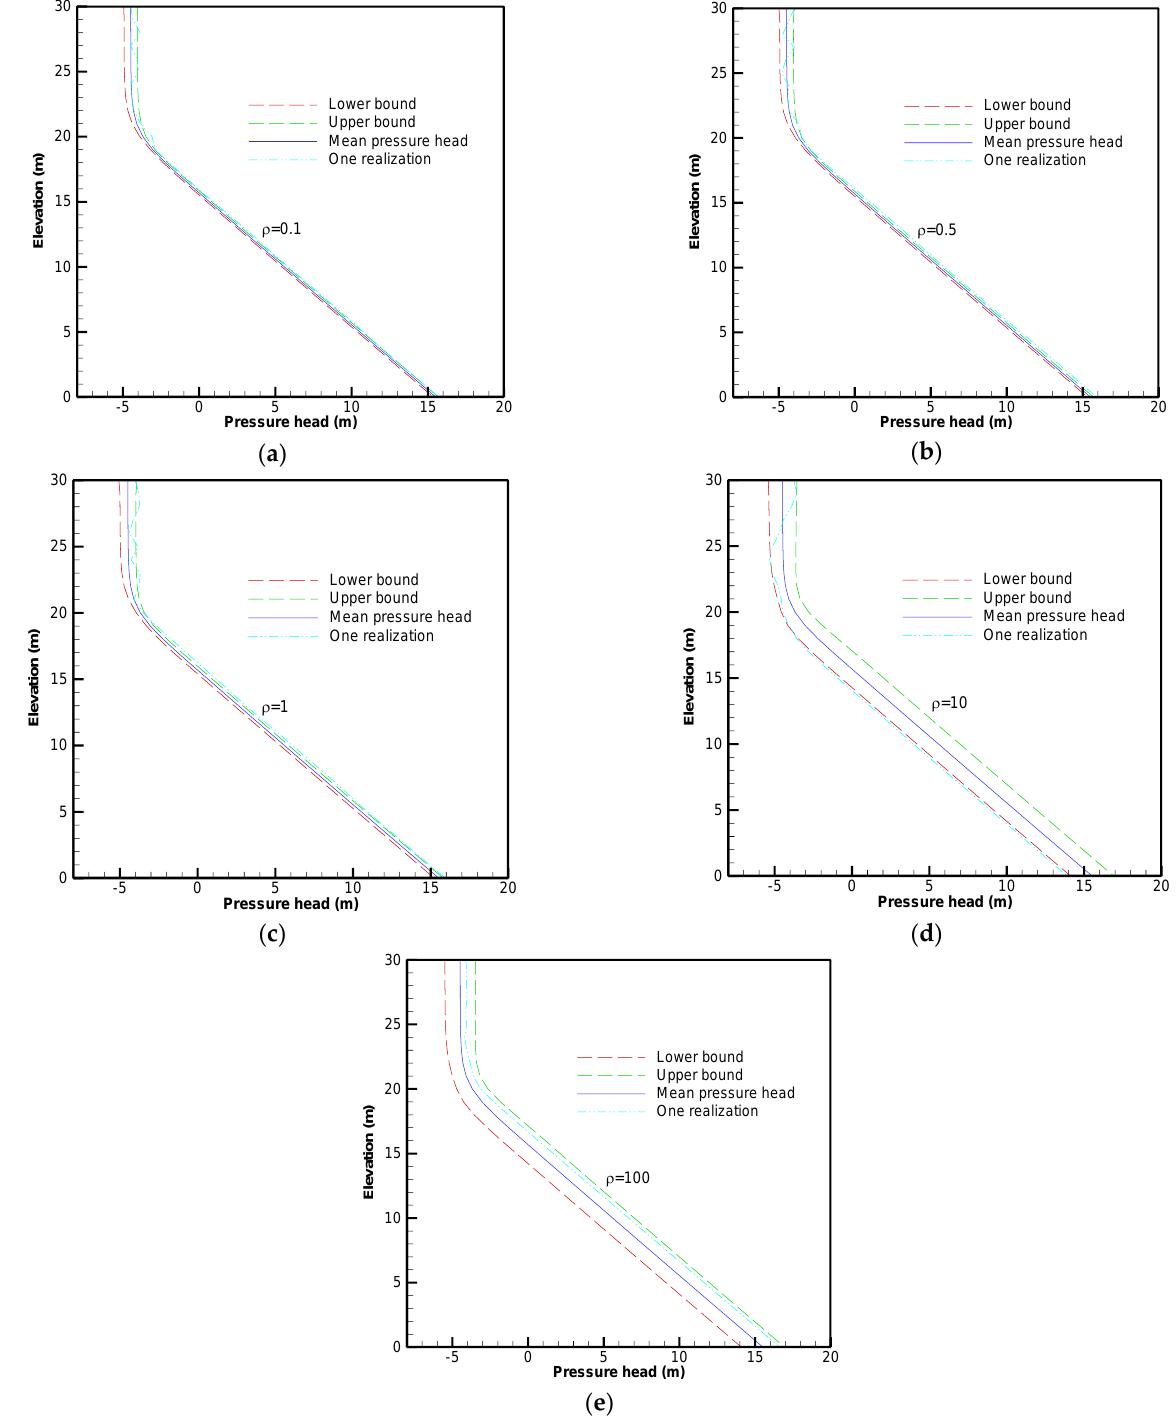
Figure 6. Pressure head response along section 1-1′ within heterogeneous slope: ( a ) ρ = 0.1 m ; ( b ) ρ = 0.5 m ; ( c ) ρ = 1 m ; ( d ) ρ = 10 m and ( e ) ρ = 100 m .